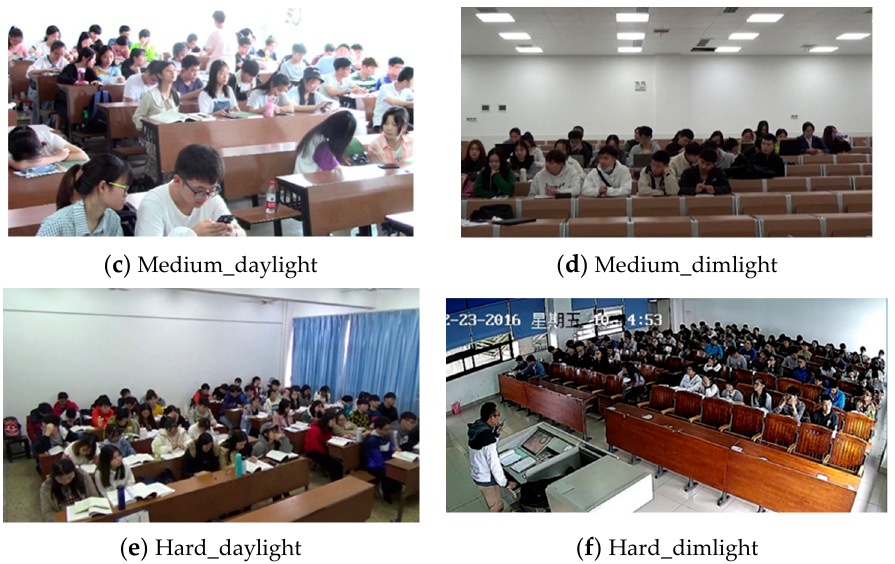
Figure 5. Partial image in Classroom-Face. According to the number of people, the data set is di- vided into Easy, Medium, and Hard. According to the light, the data set is divided into dimlight and daylight.